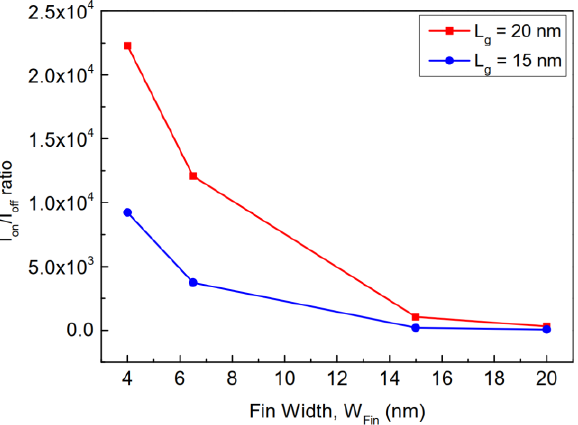
Figure 22. Behavior of I on / I off ratio as a function of fin width for FinFET devices with two different